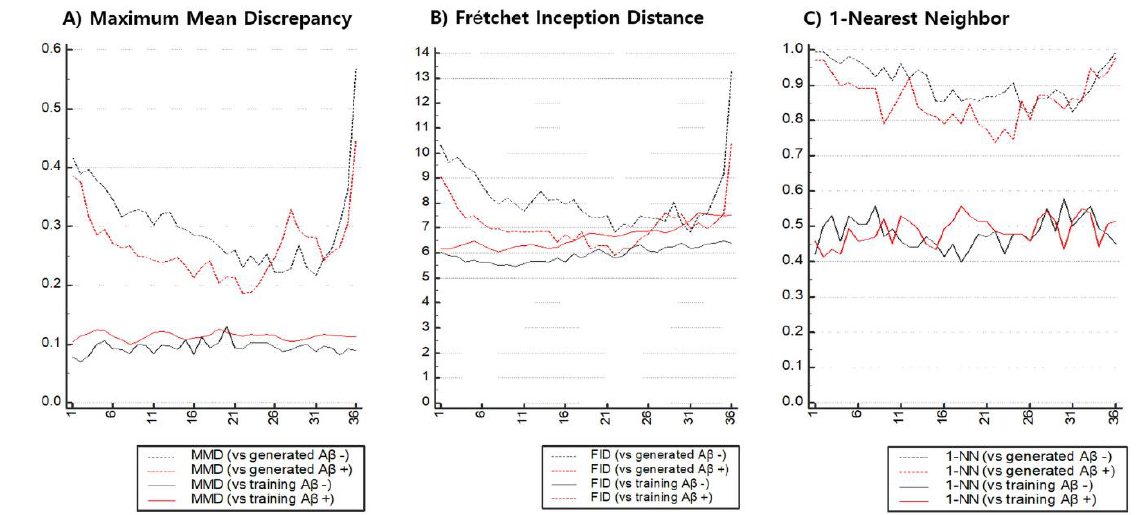
Figure 7. Quantitative measurements to estimate synthetic similarity between real and generated images with respect to each axial level of pre-processed FBB imaging.